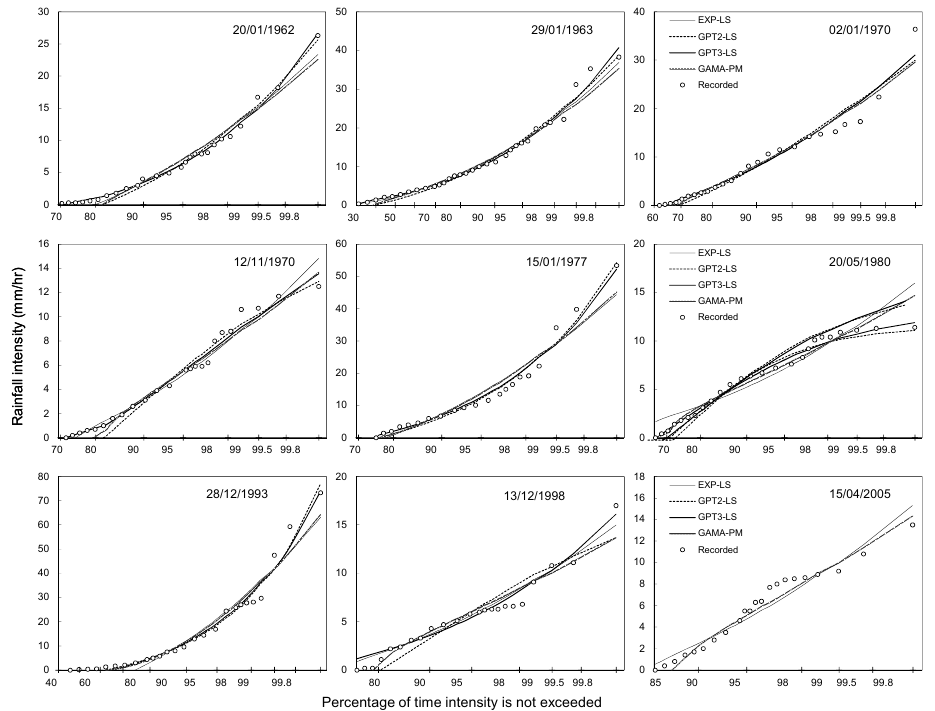
Fig. 2. Fitted cumulative density functions (CDFs) of EXP, GPT2, GPT3 and GAMA for nine events representative of varying daily rainfall depths for Melbourne. TDFs were fitted using the LS